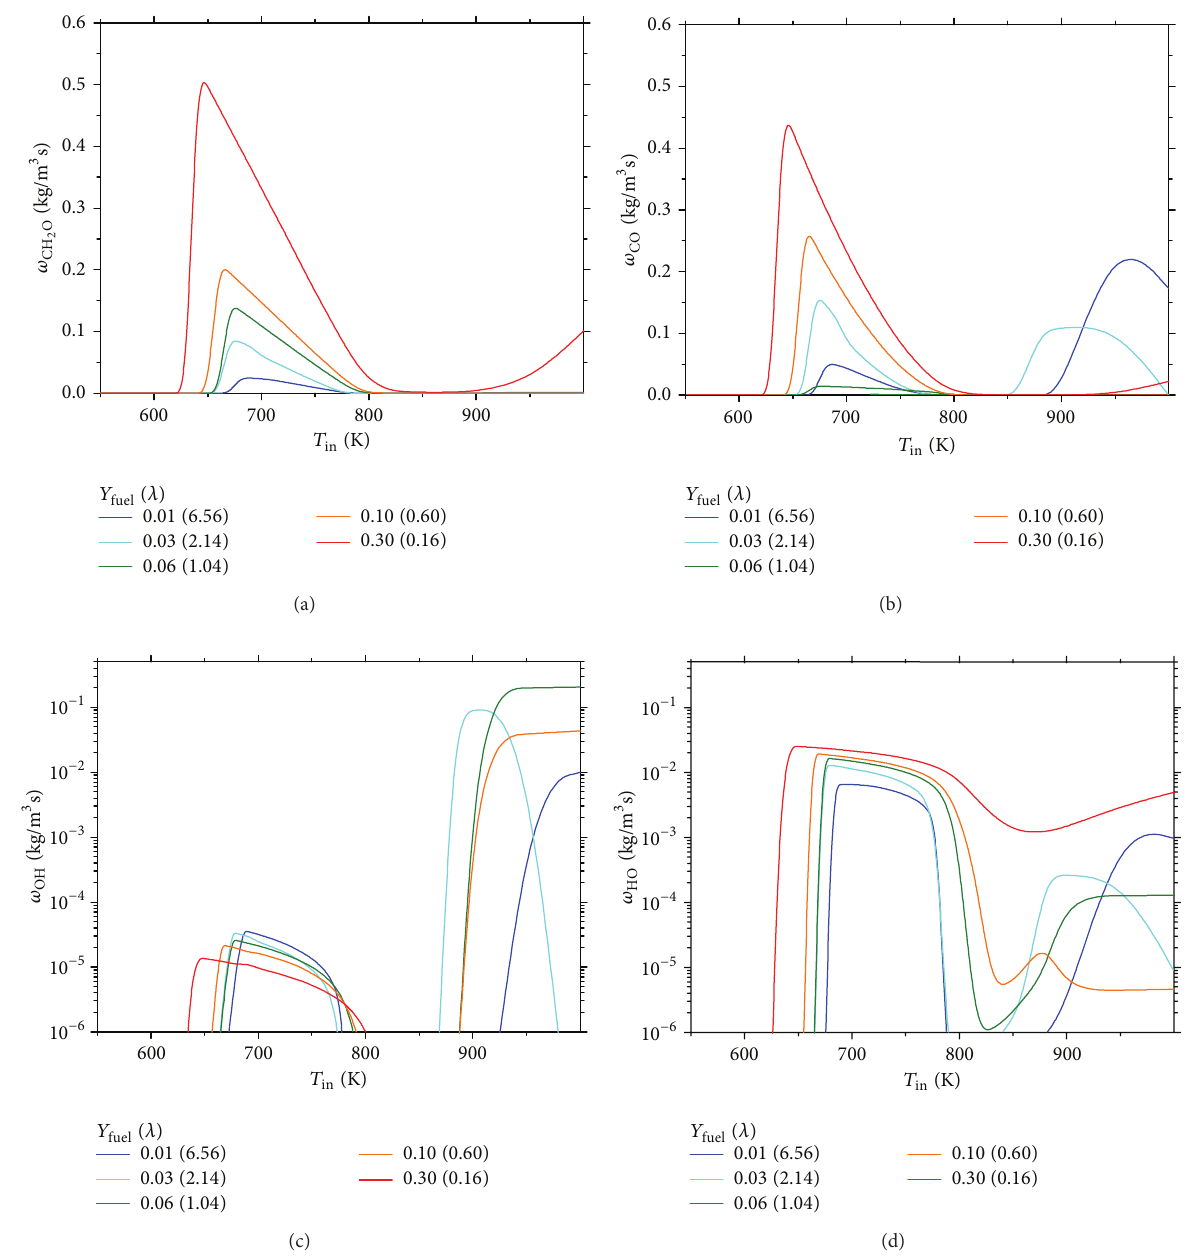
Figure 9: Predictions of CH 2 O, CO, OH, and HO 2 production rates per unit volume as a function of inlet temperature for 5 characteristic = 5 values of fuel concentration ( 𝑡 res